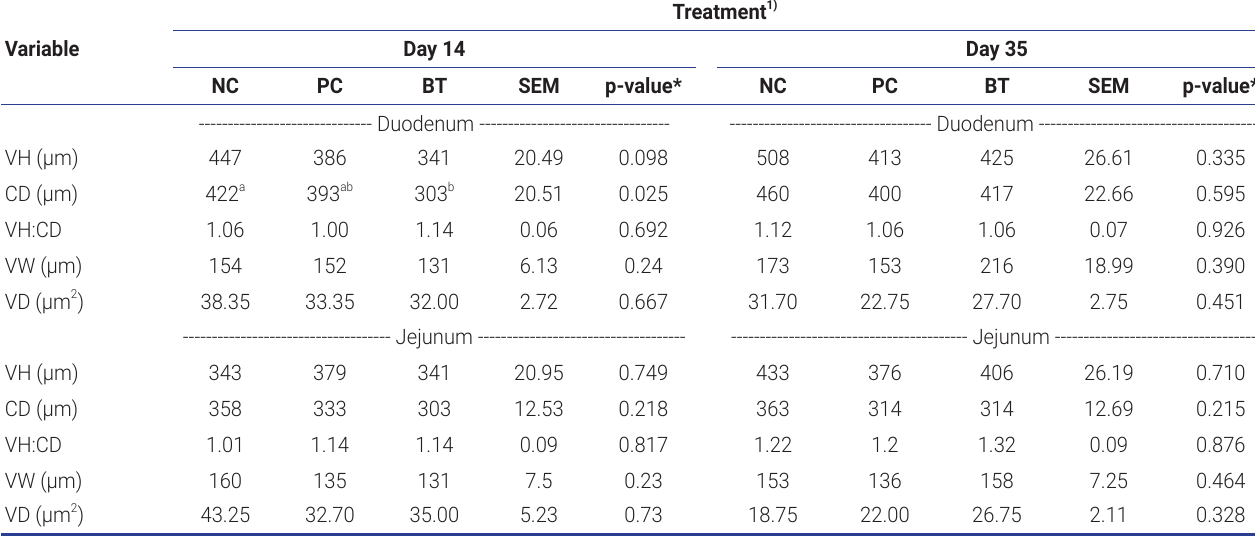
Table 3. Mean values of intestinal morphometry in the duodenum and jejunum of piglets at 14 and 35 days of experiment